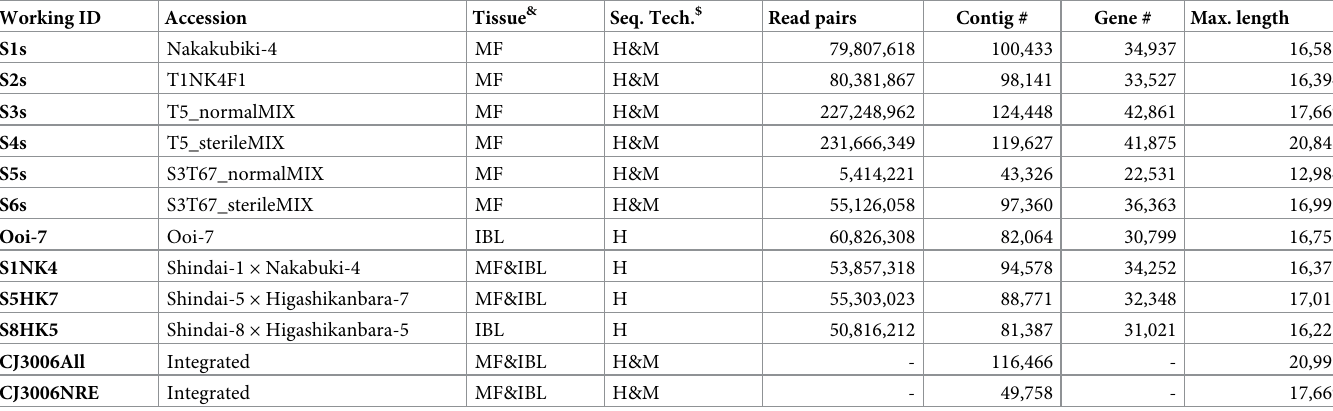
Ten RNA-Seq libraries were constructed from 10 different accessions. For S3s (T5_normal- MIX), S4s (T5_sterileMIX), S5s (S3T67_normalMIX), and S6s (S3T67_sterileMIX), RNA was extracted from several (up to 50) individuals and the mixture of RNA from progeny in each sample was sequenced. RNA-Seq was performed for S1s to S6s, as described in [22]. For the remaining libraries, RNA was extracted from different tissues (Table 1) following the method used in [22]; the mixture of RNA from these tissues was sequenced on a HiSeq2000 platform (Illumina) by Hokkaido System Science Co., Ltd, Sapporo, Japan. We performed ISO-Seq (iso- form sequencing) using the RNA of S2s and sequenced on PacBio RS II (Pacific Biosciences) with four cells by P3C5 chemistry by Takara Bio Inc., Shiga, Japan. Table 1. Statistics of raw and mapped reads. Working ID